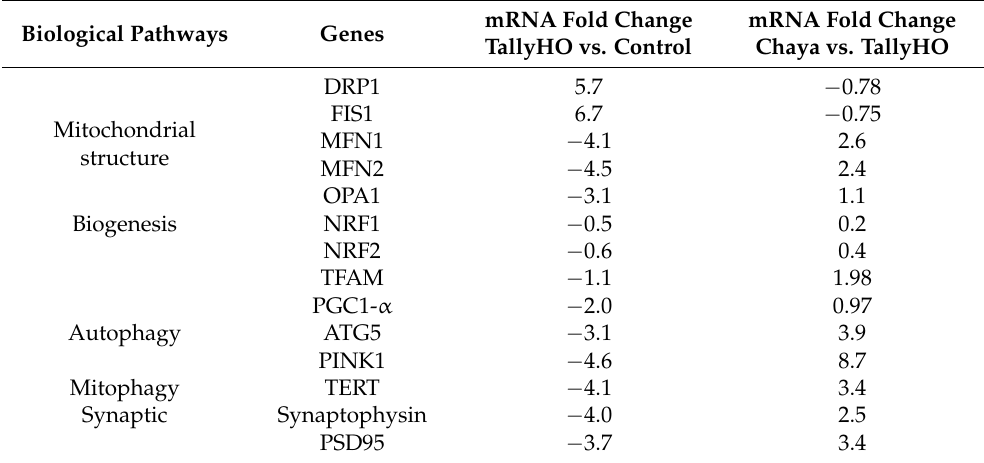
Table 4. A comparison of the mRNA fold changes of mitochondrial structural, synaptic, biogenesis, autophagy, and mitophagy genes in TH mice fed with chaya and TH mice fed with regular chow. mRNA Fold Change mRNA Fold Change Biological Pathways Genes TallyHO vs. Control Chaya vs. TallyHO DRP1 5.7 − 0.78 FIS1 6.7 − 0.75 Mitochondrial MFN1 − 4.1 2.6 structure MFN2 − 4.5 OPA1 Biogenesis NRF1 −